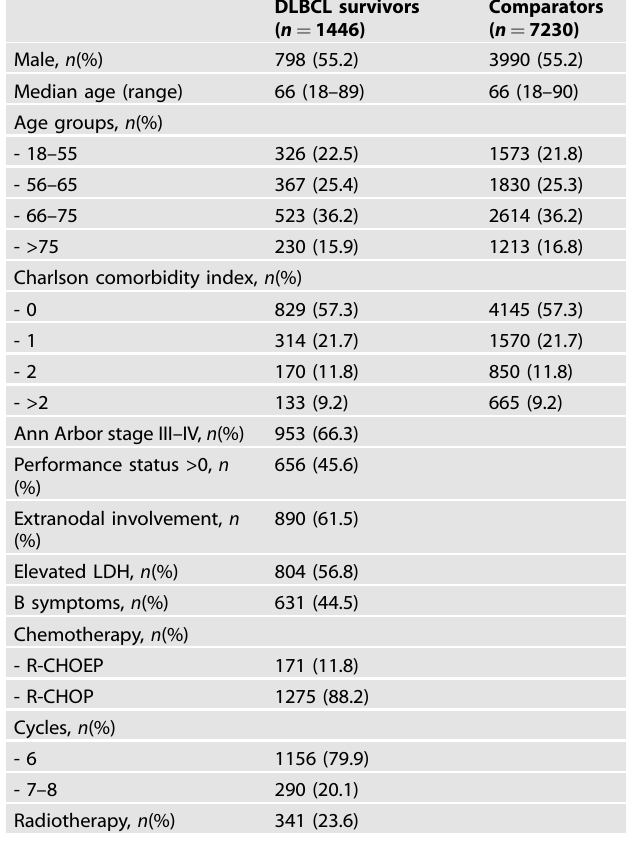
Table 1. Diagnostic clinicopathological characteristics of all Danish DLBCL patients in CR after 6 – 8 cycles of R-CHOP-like therapy and free of relapse 90 days after response